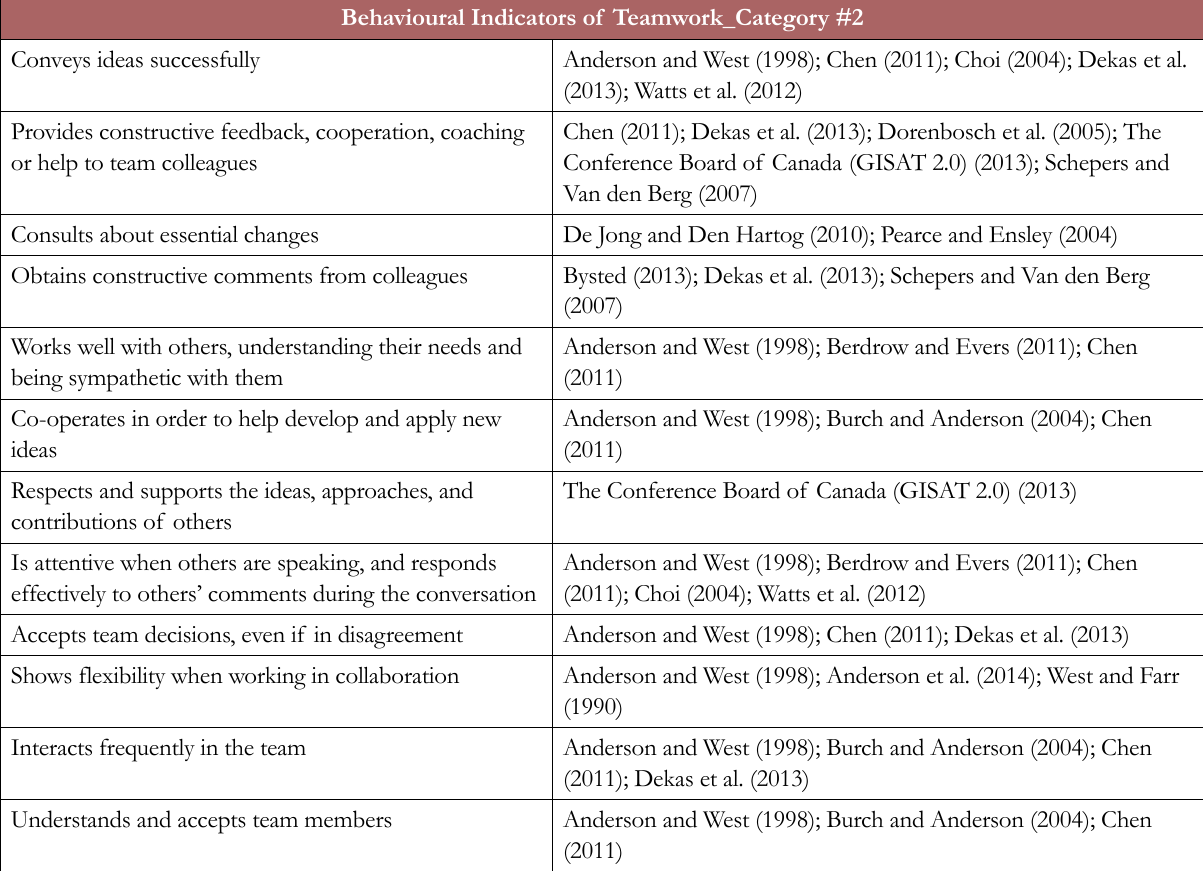
Table 19. Behaviours showing “making the team work